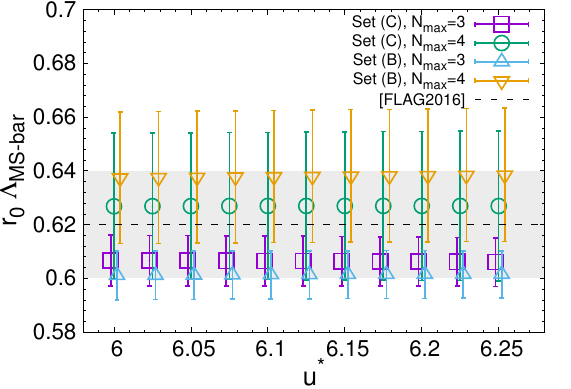
Figure 9 . The intermediate scale ( u (cid:3) = g 2 dashed line is the known value (cid:3) are slightly shifted horizontally for clarity.